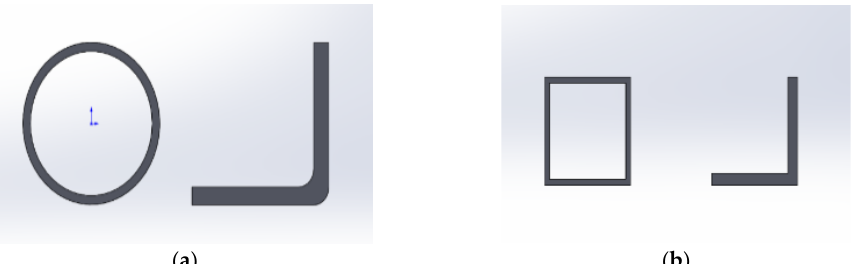
Figure 2. This figure shows the model before and after the simplification of the frame: ( a ) shape before simplification; ( b ) simplified